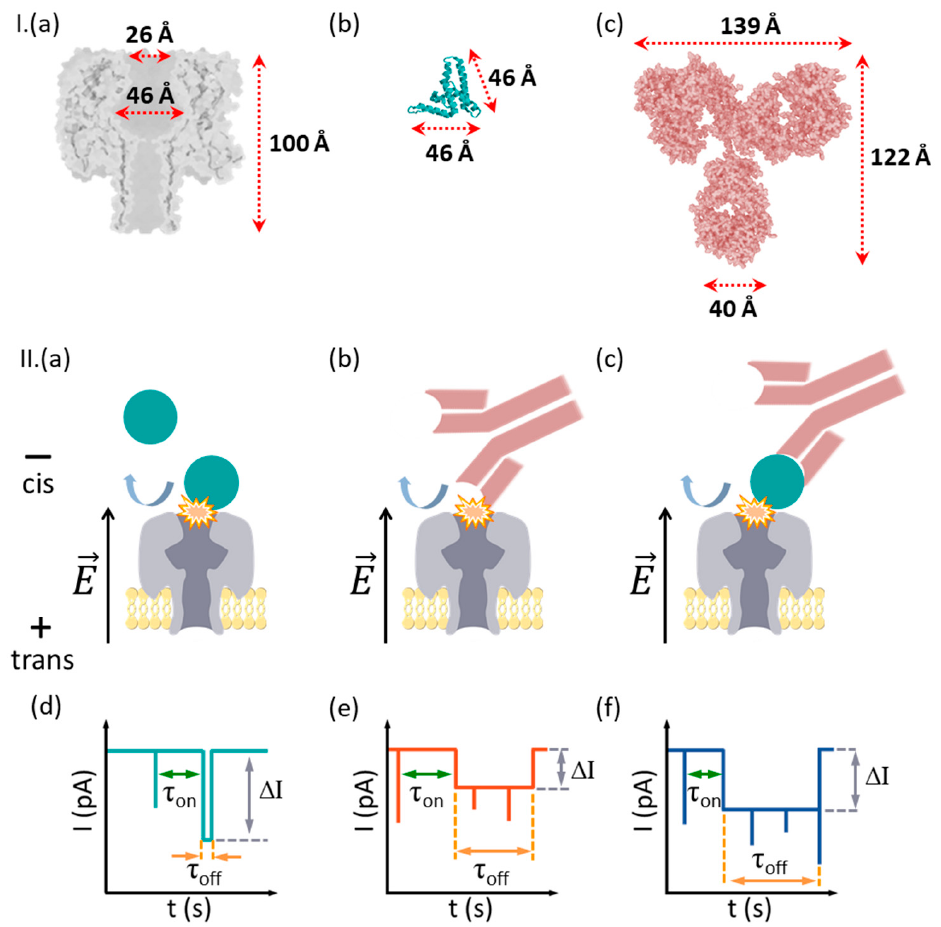
Figure 1. Simplified description of the measurement principle. ( I ) In ( a – c ) are presented at a similar scale the homo-heptameric α -HL protein nanopore, HBeAg protein antigen and its monoclonal antibody Ab(HBeAg). ( II ) Due to the exclusion volume effects, the nanopore cannot capture and accommodate inside it the HBeAg ( a ), Ab(HBeAg) antibody ( b ), or HBeAg–Ab(HBeAg) complexes formed in solution ( c ). The electrophoresis of anionic HBeAg, Ab(HBeAg) antibody, or HBeAg– Ab(HBeAg) complexes toward the nanopore result in collisional interactions with the nanopore, seen as stochastic spikes in the ionic current ( d – f ), correlated with the transient obturation of the α -HL’s vestibule entrance area by an incoming analyte. Such events are characterized by the blockade depth ( Δ I), dwell time ( τ off ), and inter-events intervals ( τ on ). In certain cases, a series of fast-occurring spikes are seen during a single collisional event (see schematics in panels e and f, the capture events), which we posit to reflect stochastic, spatial re-arrangements of the captured analyte at the nanopore’s mouth.